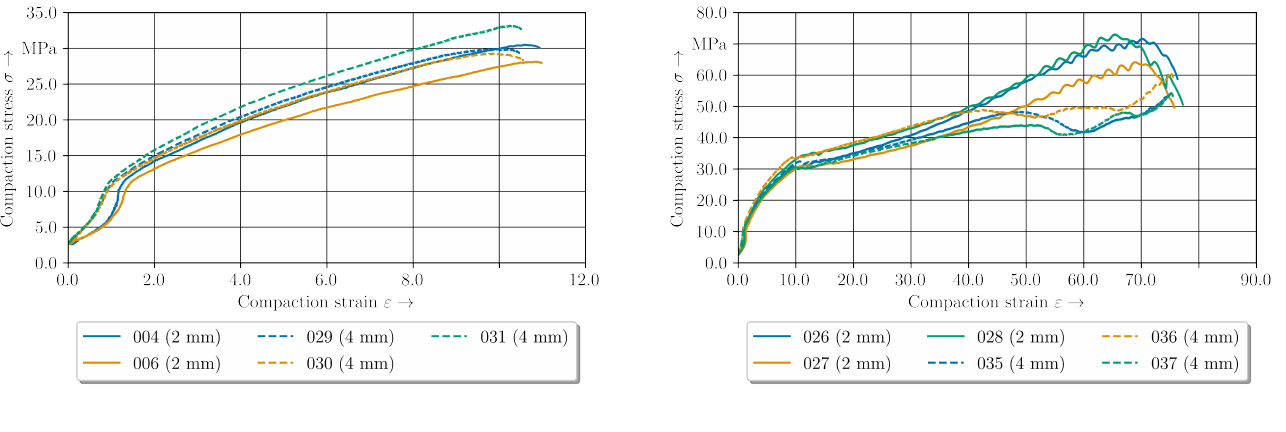
Figure 11. Compaction curves at 160°C for two configurations. ( a ) 10% compaction level. ( b ) 75% compaction